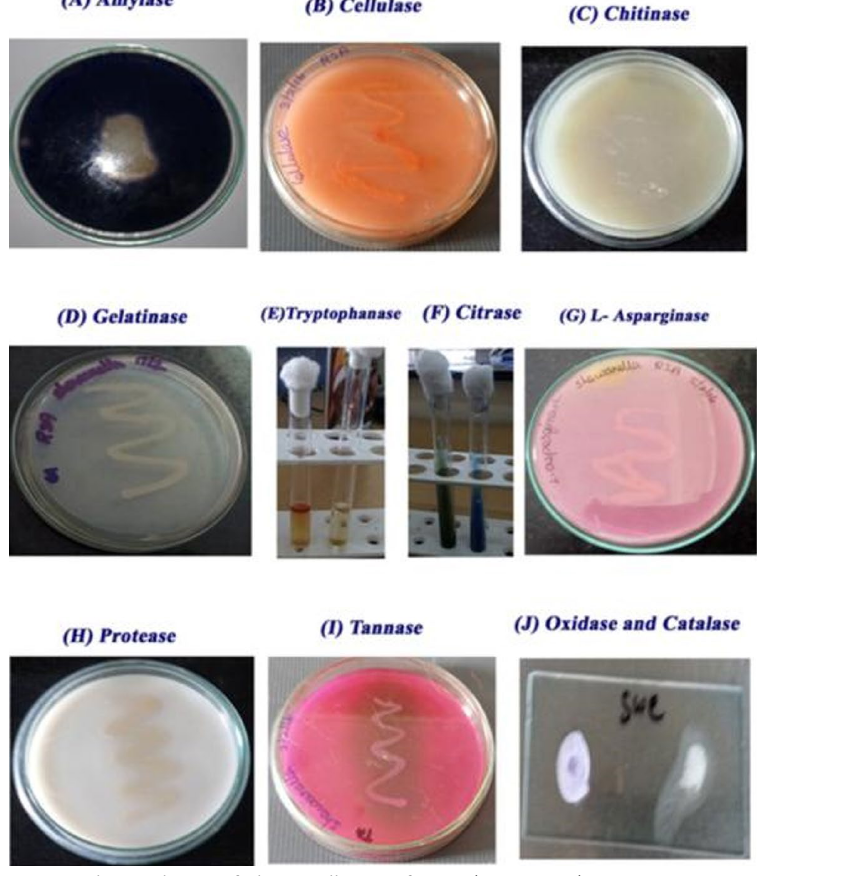
Fig.3. Biochemical tests of Shewanella putrefaciens